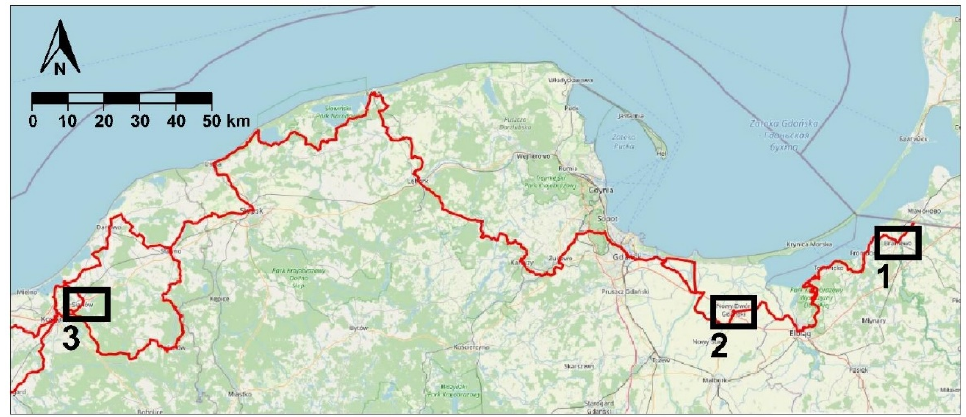
Figure 2. (1) Braniewo, (2) Nowy Dwór Gda ń ski, and (3) Sianów along the Pomeranian Way of St. James.